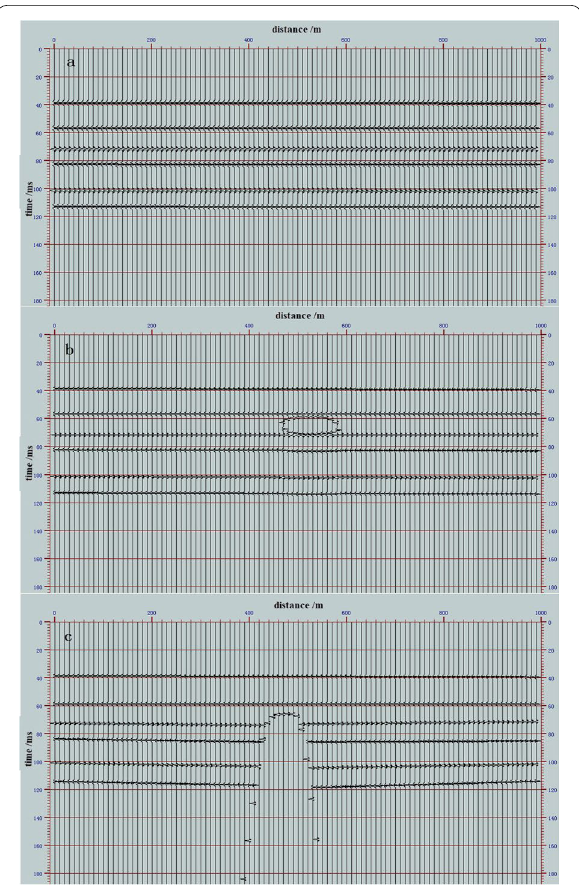
Fig. 2 Stratigraphic model, where a is a normal stratigraphic model; b is a biomethane shallow gas model; and c is a pyrolysis shallow gas model